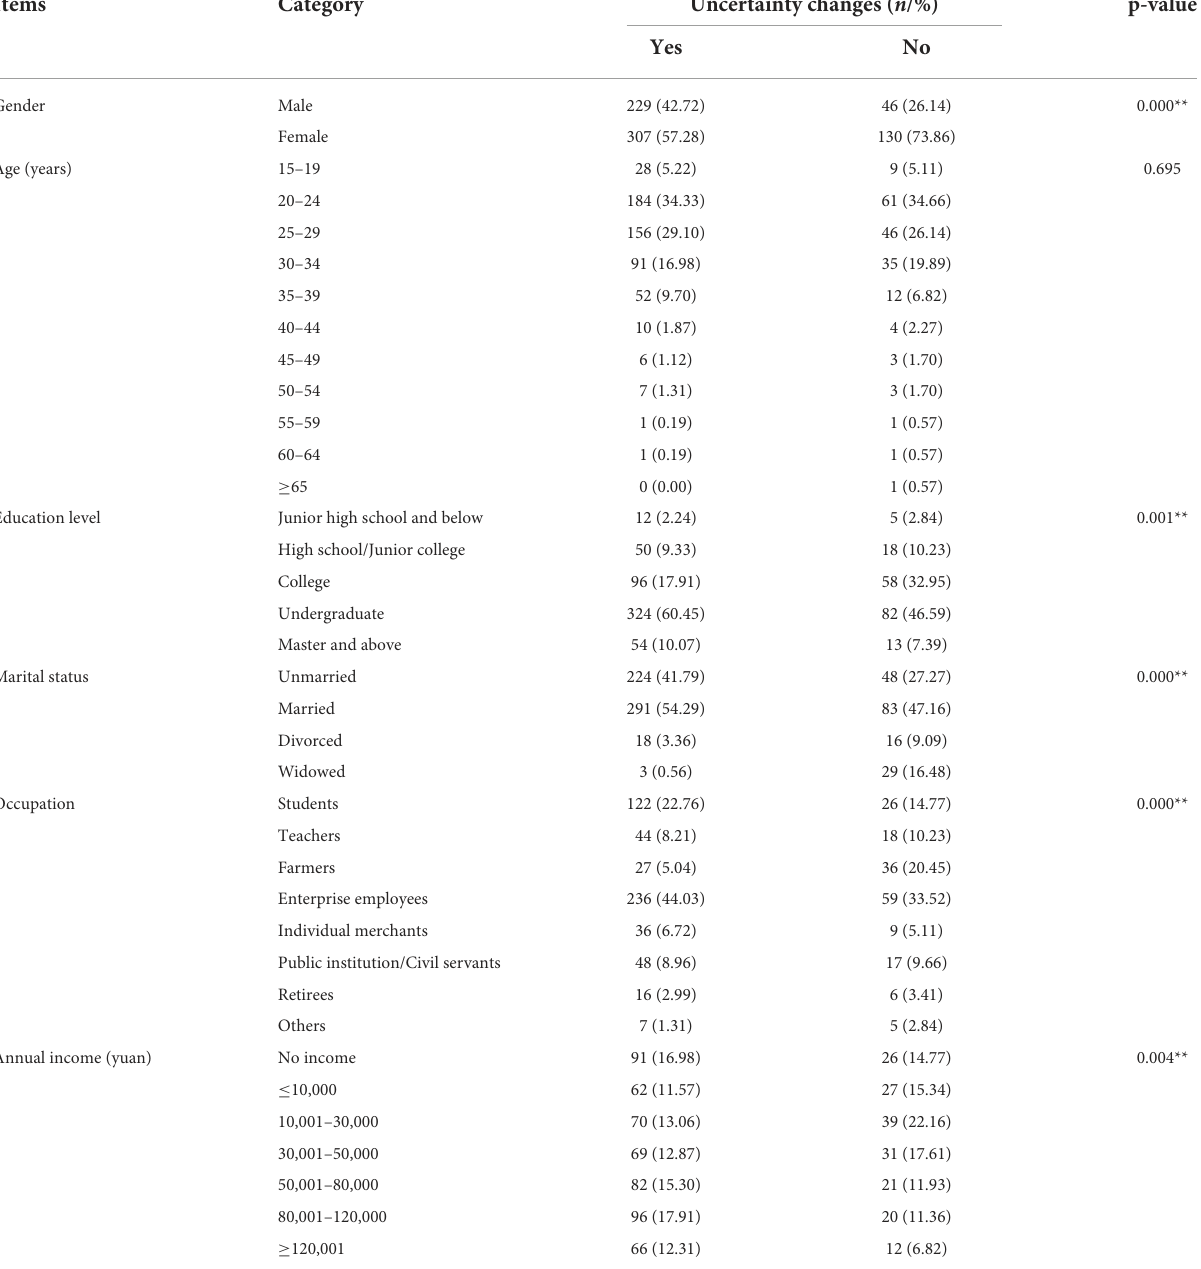
TABLE 4 A chi-square test of whether sociodemographic and uncertainty change financial asset allocation decisions ( N = 712).